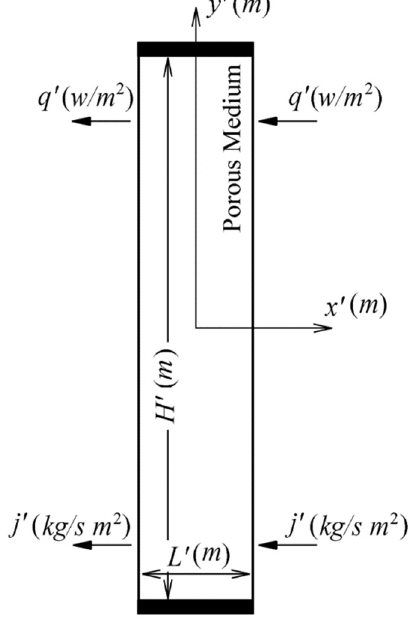
Figure 1. The physical model and coordinate system.